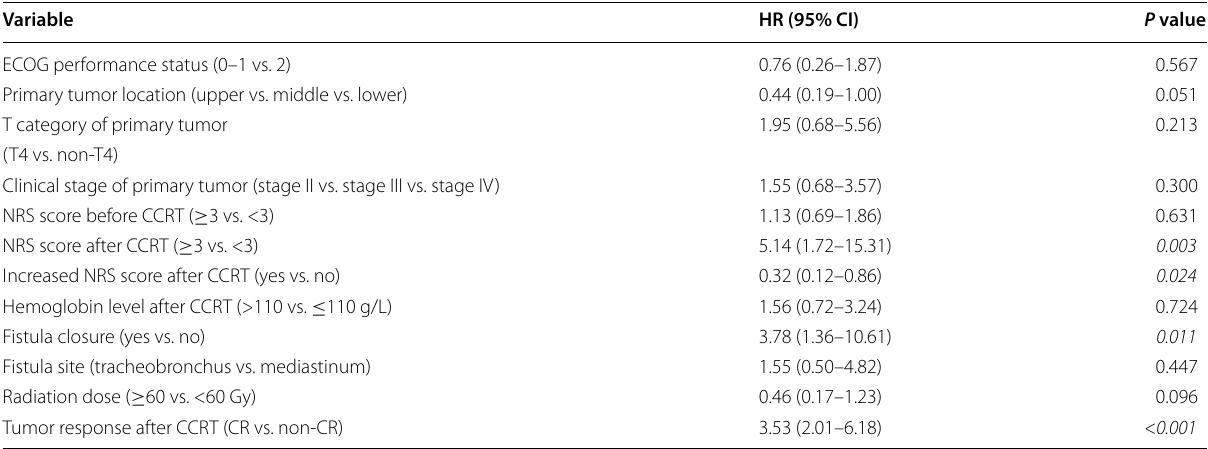
HR, hazard ratio; CI, confidence interval. ECOG, Eastern Cooperative Oncology Group; NRS, nutrition risk screening; CCRT, concurrent chemoradiotherapy; CR, complete